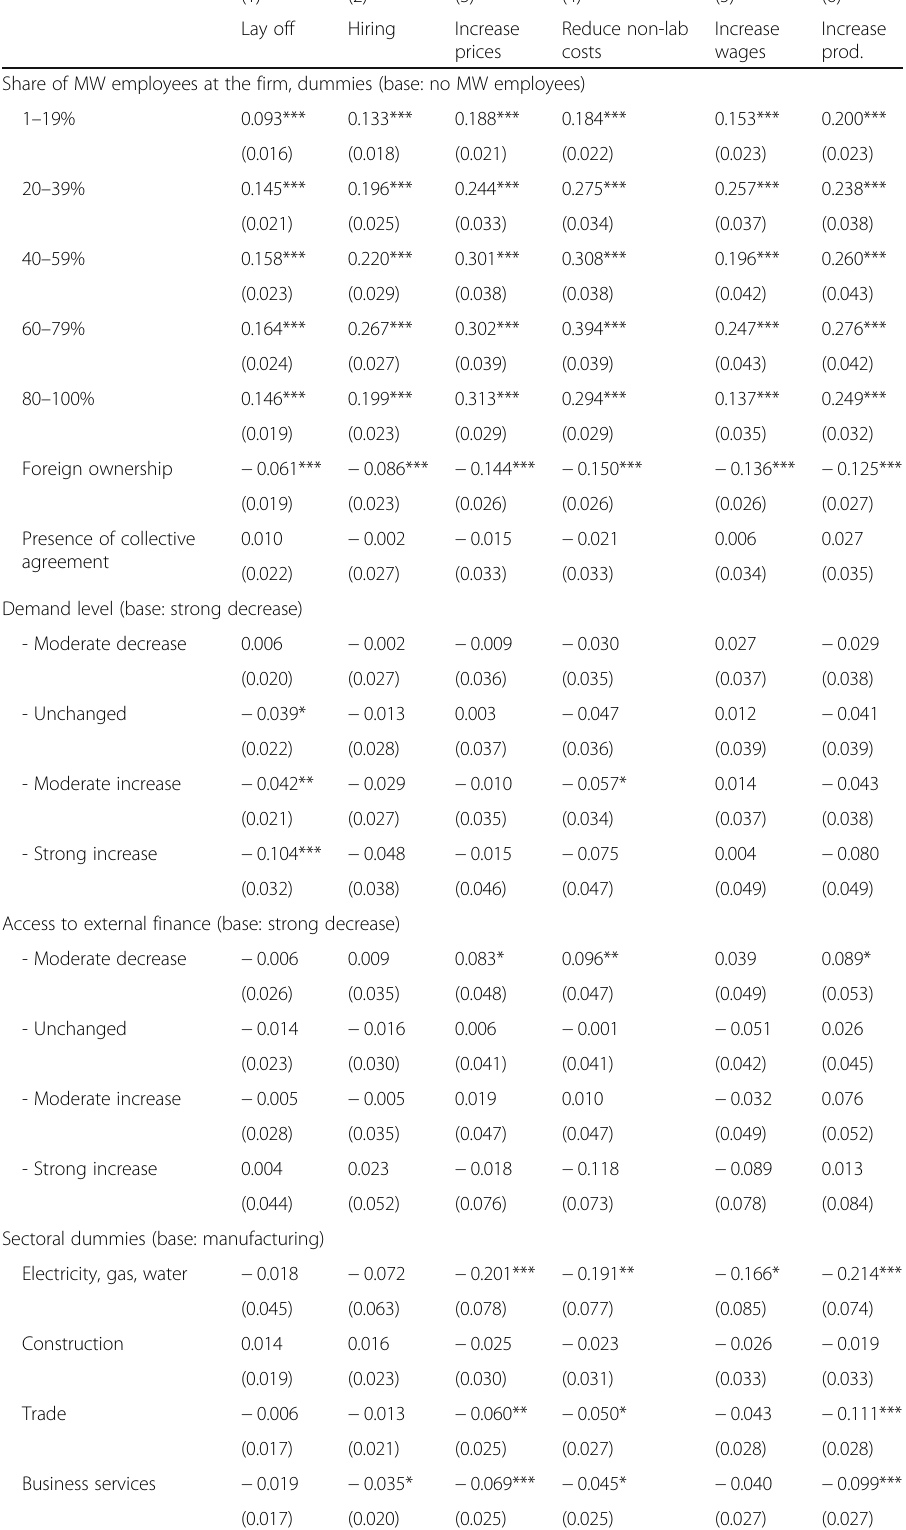
Table 12 Multivariate probit of adjustment channel relevance, average marginal effects (all channels; sample restricted to Baltic countries and